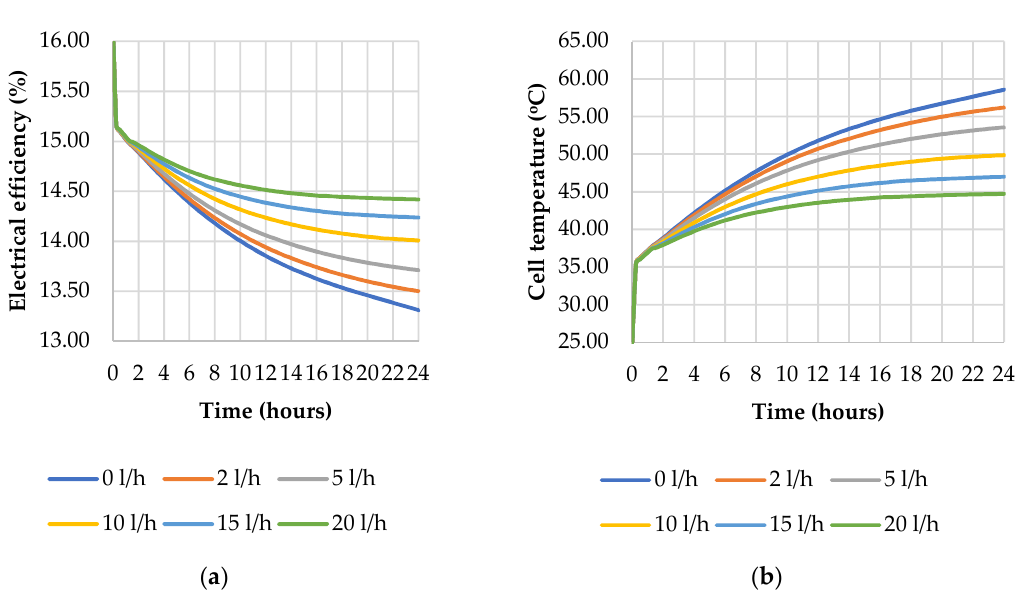
Figure 11. The variation of the ( a ) electrical efficiency; ( b ) cell temperature; as a function of the flow rate to the consumer.